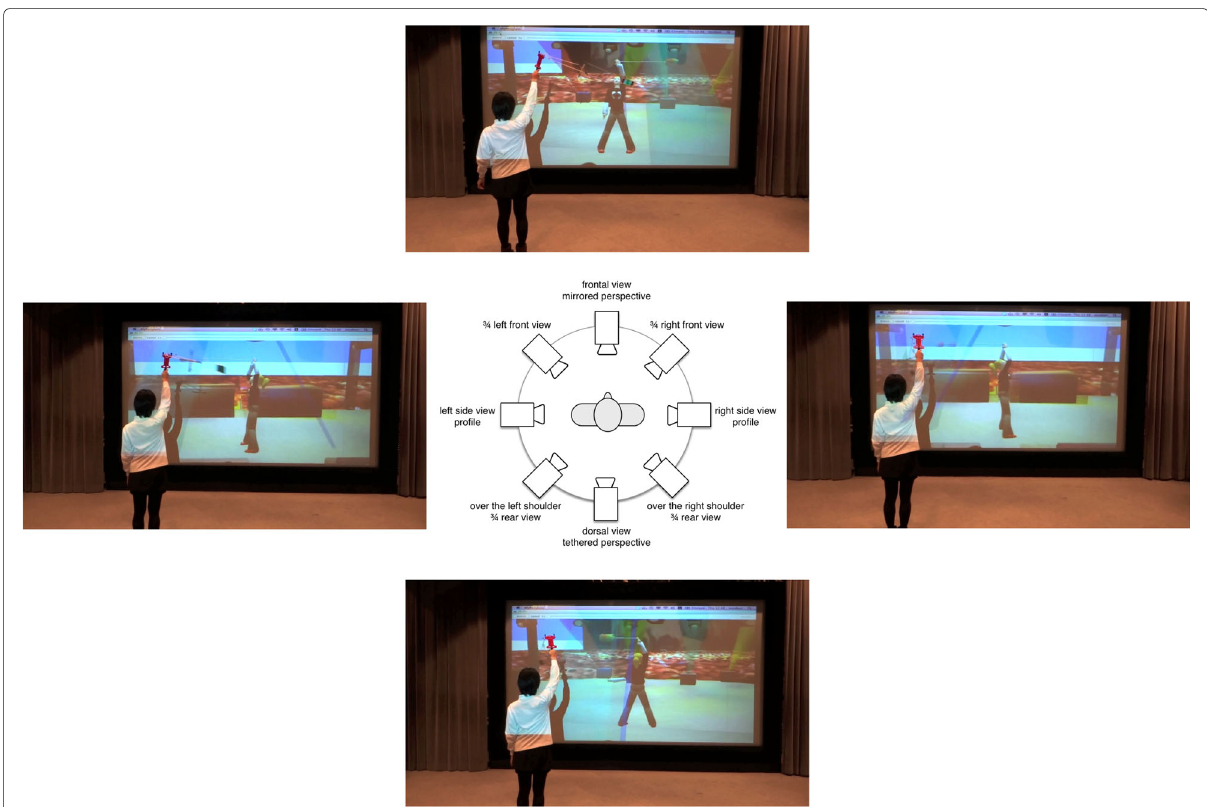
Fig. 14 As the virtual camera orbits a puppet representing the user, the self-conscious, ambidextrous avatar switches hands. In this example, phase perturbation is disabled, so affordance projection is not aligned: World-referenced affordance azimuth is not adjusted, so